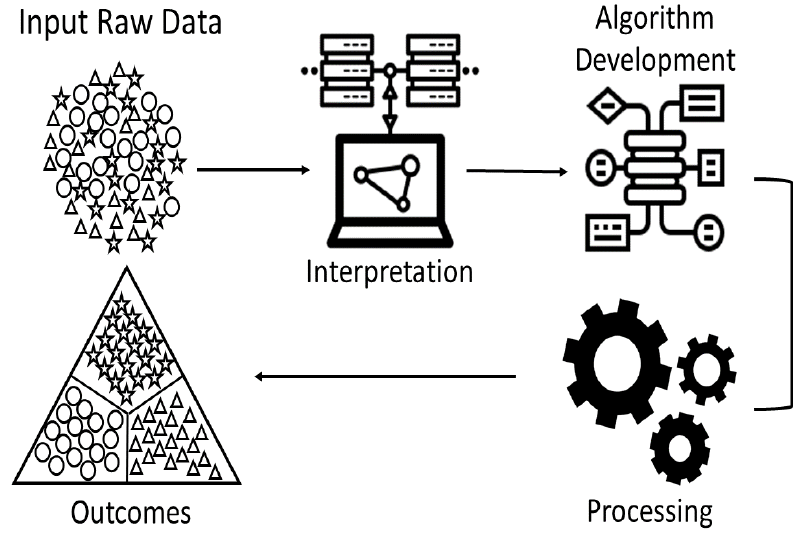
Figure 2. Workflow diagram of unsupervised learning.